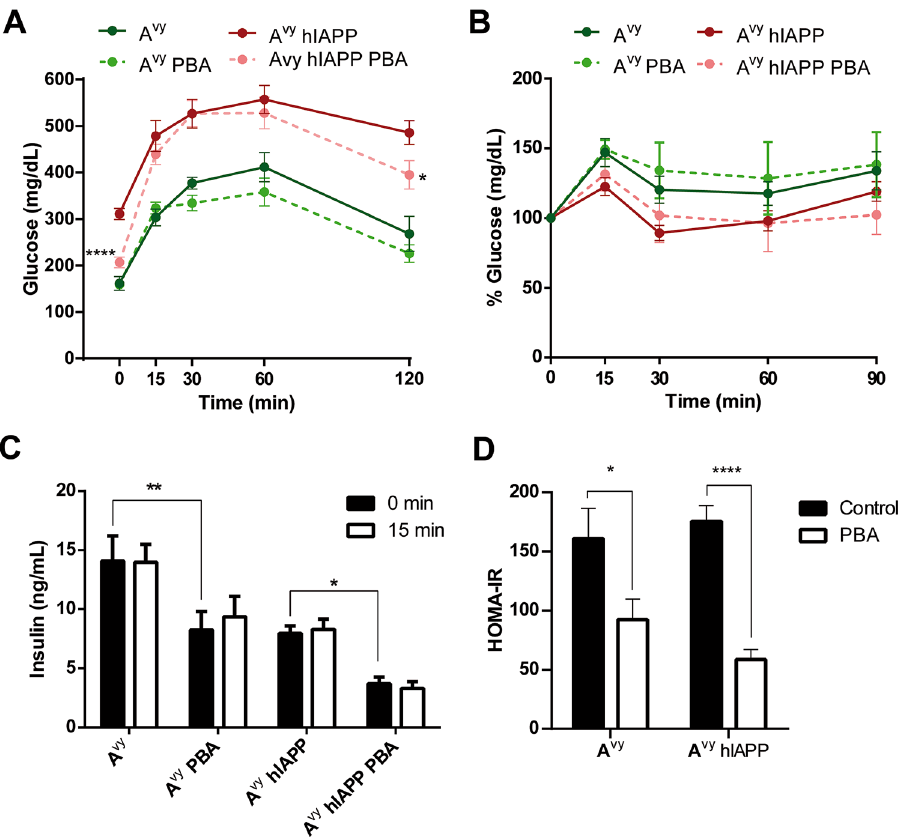
Figure 4. PBA treatment improves glucose homeostasis in A vy hIAPP mice. (A) Glucose tolerance tests (1 g/ kg glucose) in 18-week-old A vy and A vy hIAPP mice treated or not with PBA for 10 weeks. ( B ) Insulin tolerance tests (0.75 U/kg insulin). Percentages of glycemia values respect to the initial value are represented. (C) Plasma insulin levels after a 5-h fasting (0 min) or 15 min after glucose injection (15 min). (D) HOMA-IR index was calculated using 5-h fasting glucose and insulin levels. Results are presented as mean ± SEM of 4–7 mice/group. Statistical analyses were performed by using (A) Student’s t test at each time point comparing each treated group vs. the respective non-treated control group, or (C,D) two-way ANOVA followed by Tukey’s post hoc tests: *p < 0.05, **p < 0.01, ****p <